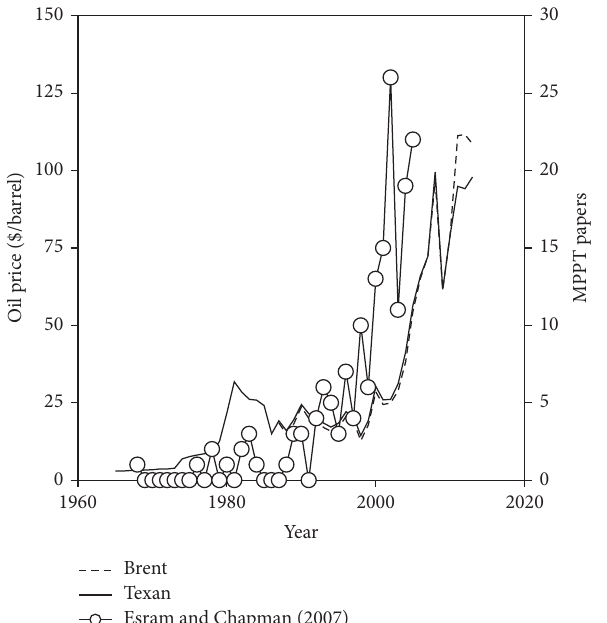
Figure 1: Left axis: oil prices per barrel (Brent and West Texas Intermediate). Right axis: number of papers published between 1968 and August 2005 according to Esram and Chapman.